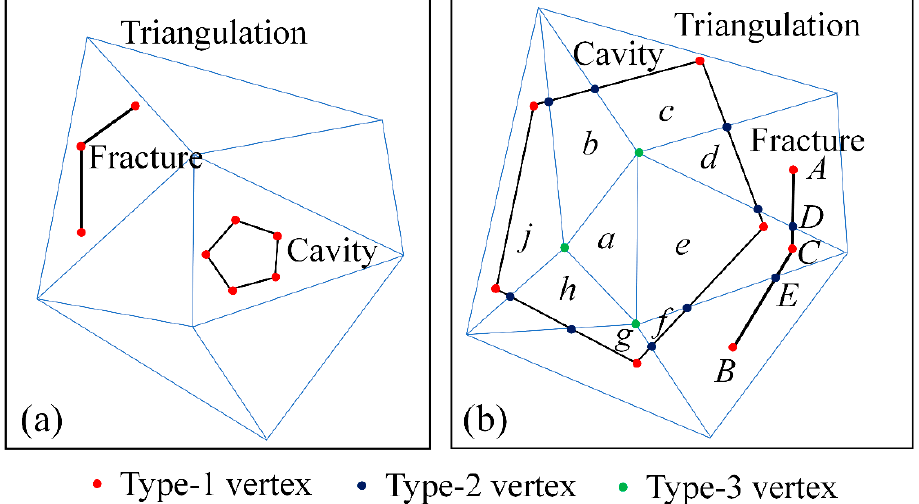
Figure 6. The intersection of the triangulation and the geometries of the fractures and cavities. ( a ) The fracture or cavity in the interior of a triangle; ( b ) the fracture or cavity covers multiple triangles.